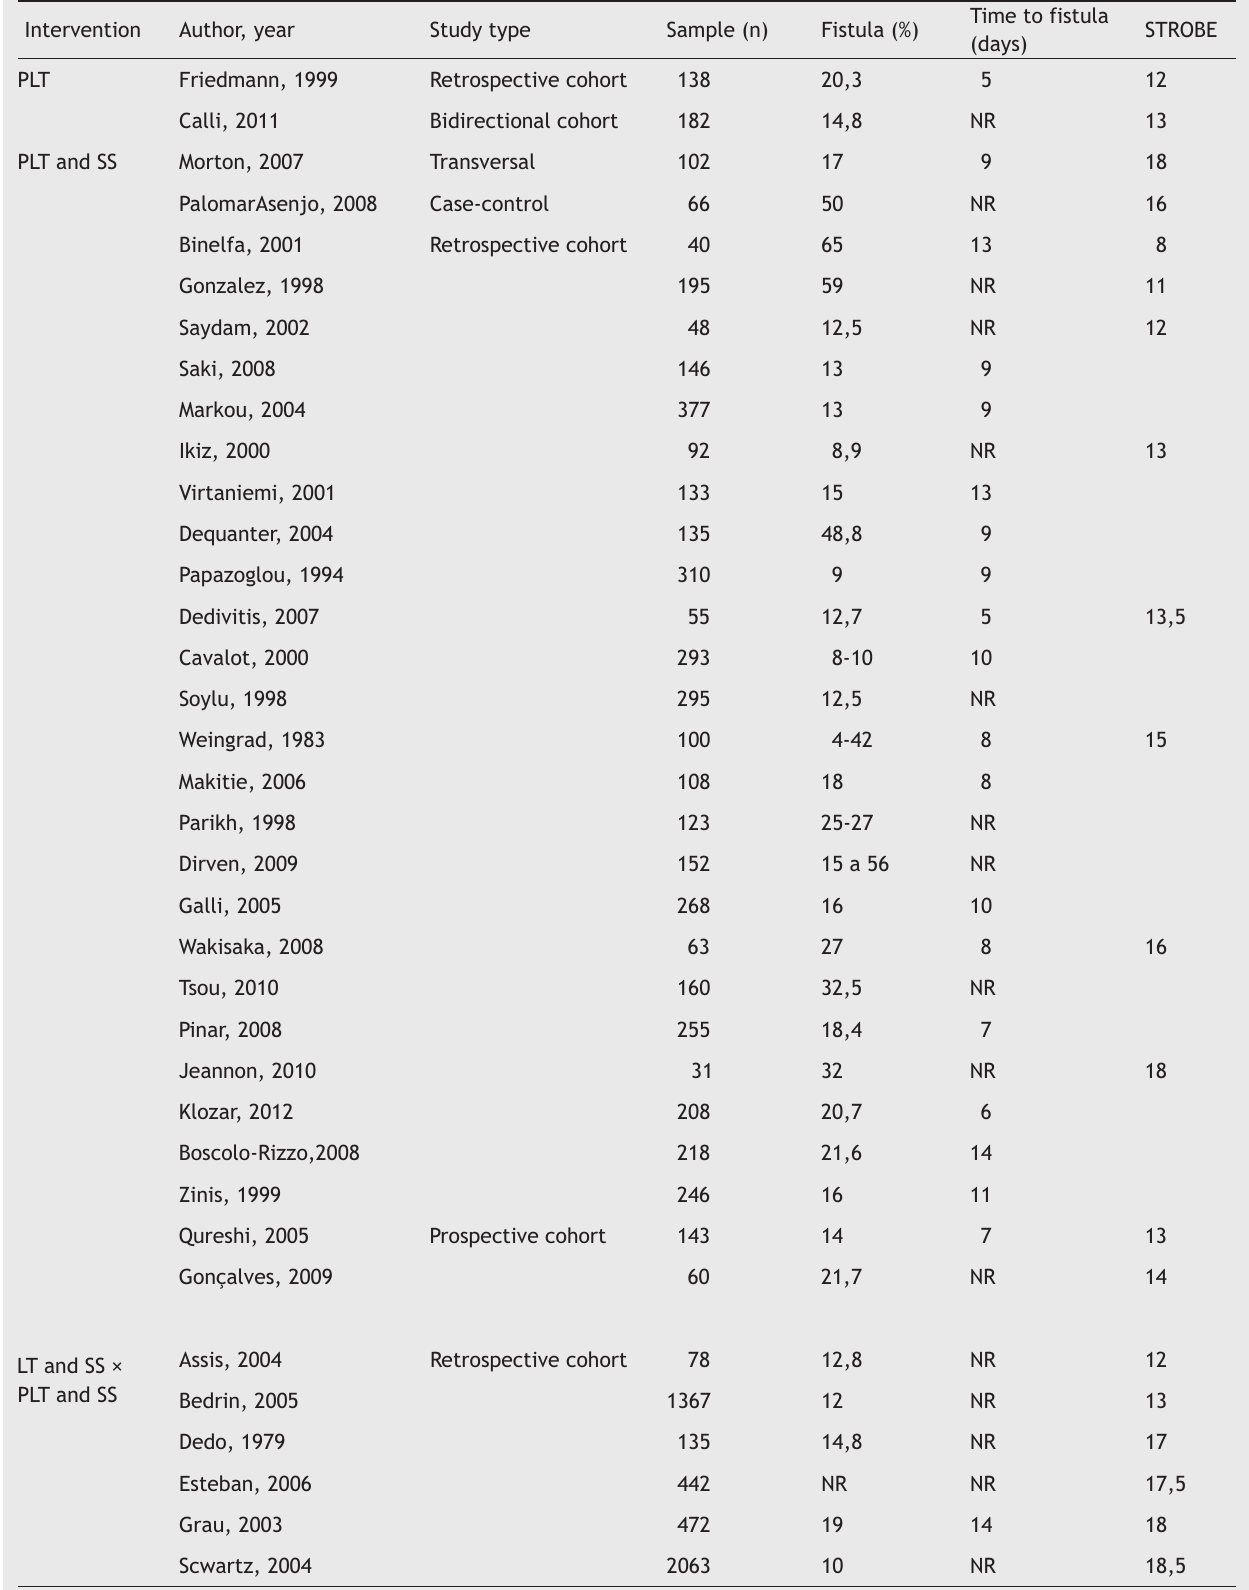
Table 1 Characterization of the selected studies by type of intervention with STROBE classification and sample size.